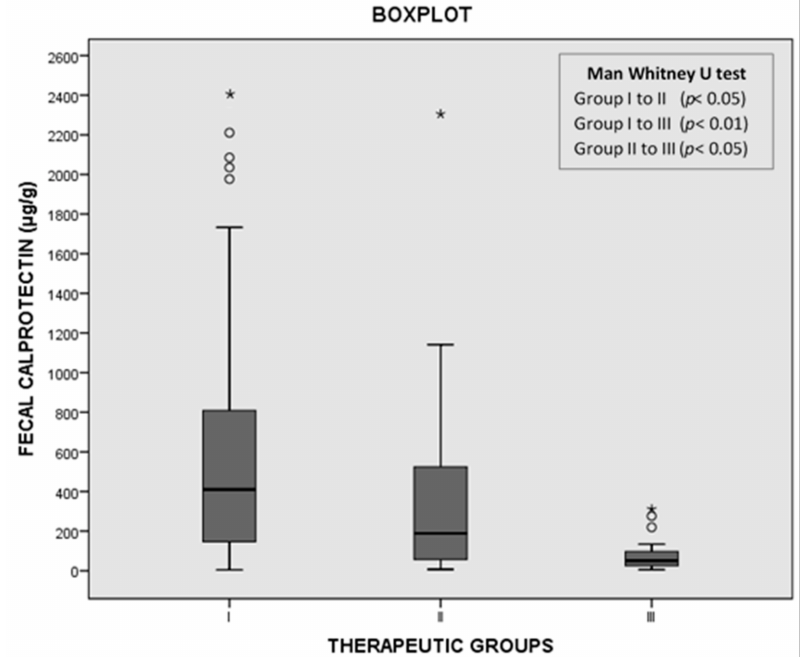
Figure 2. Distribution of fecal calprotectin (fCP) levels among groups I, II, and III. * maximum value in the data, ◦ potential outlier.